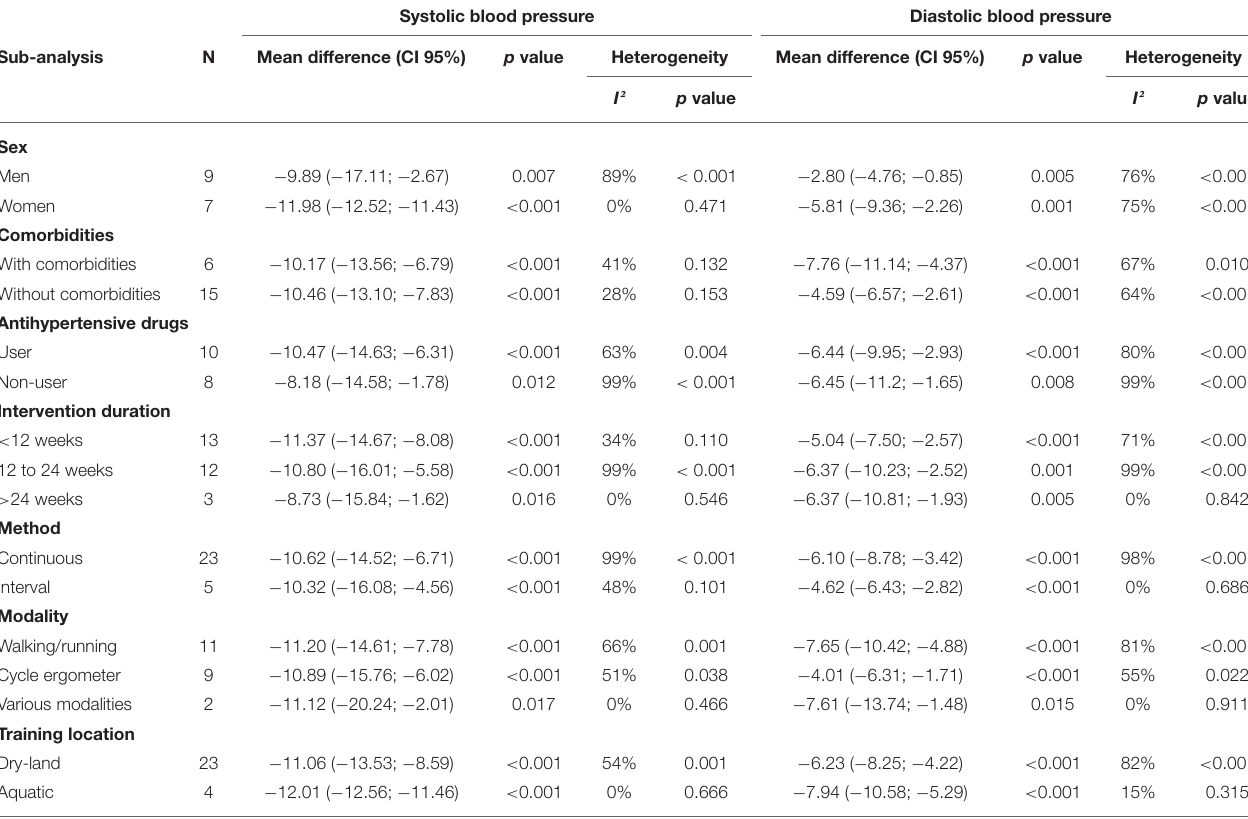
TABLE 4 | Meta-analysis results.